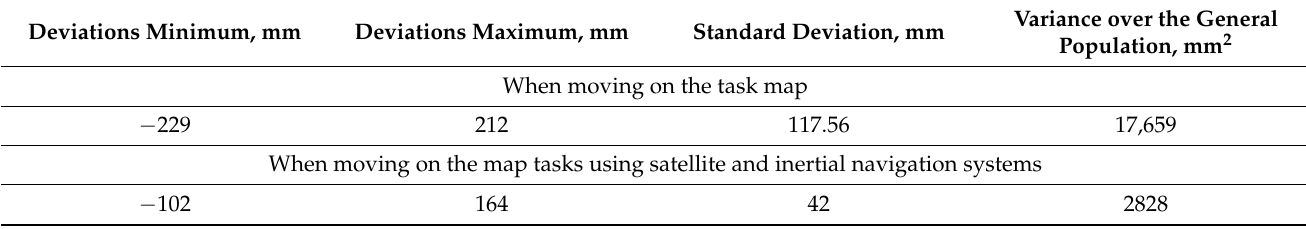
Table 2. Results of the field